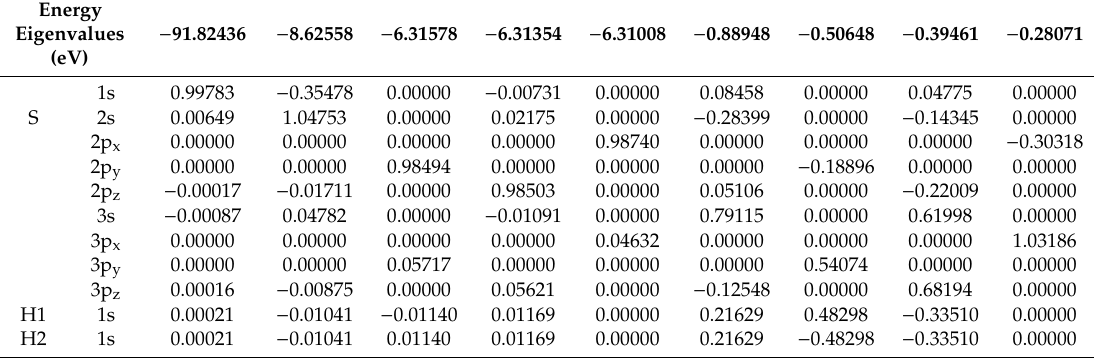
Table 1. Energy eigenvalues of the molecular orbitals of H 2 S with coe ffi cients a ik as in Equation (10). Energy Eigenvalues